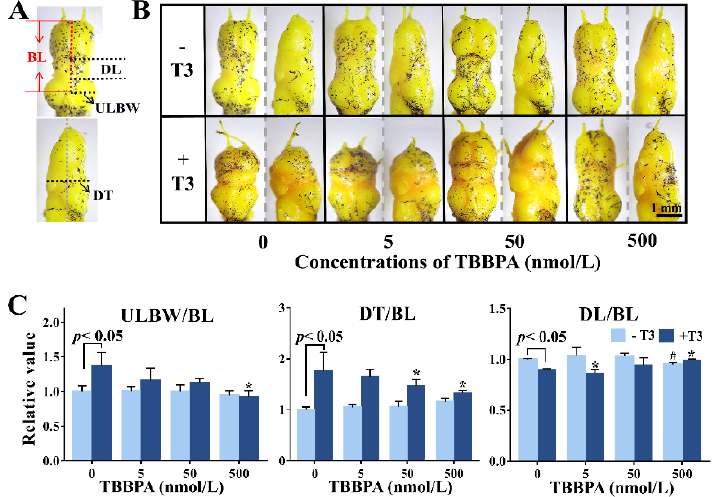
Figure 3. Brain morphological changes of premetamorphic Xenopus laevis following four-day expo- sure to tetrabromobisphenol A (TBBPA) in the absence or presence of 1 nmol/L T3. ( A ) Schematic description of measurement parameters. DL for diencephalon length, ULBW for unilateral brain width, BL for brain length, and DT for diencephalon thickness. ( B ) Representative morphology of the elevation view and side view of the brain. ( C ) Quantitative analysis result of brain parameters. Each parameter was normalized by the mean value of the solvent control tadpoles. Data are shown as mean ± SD. # indicates significant differences between TBBPA treatment and solvent control treat- ment ( p < 0.05). * indicates significant differences between TBBPA + T3 treatment and T3 treatment ( p < 0.05).